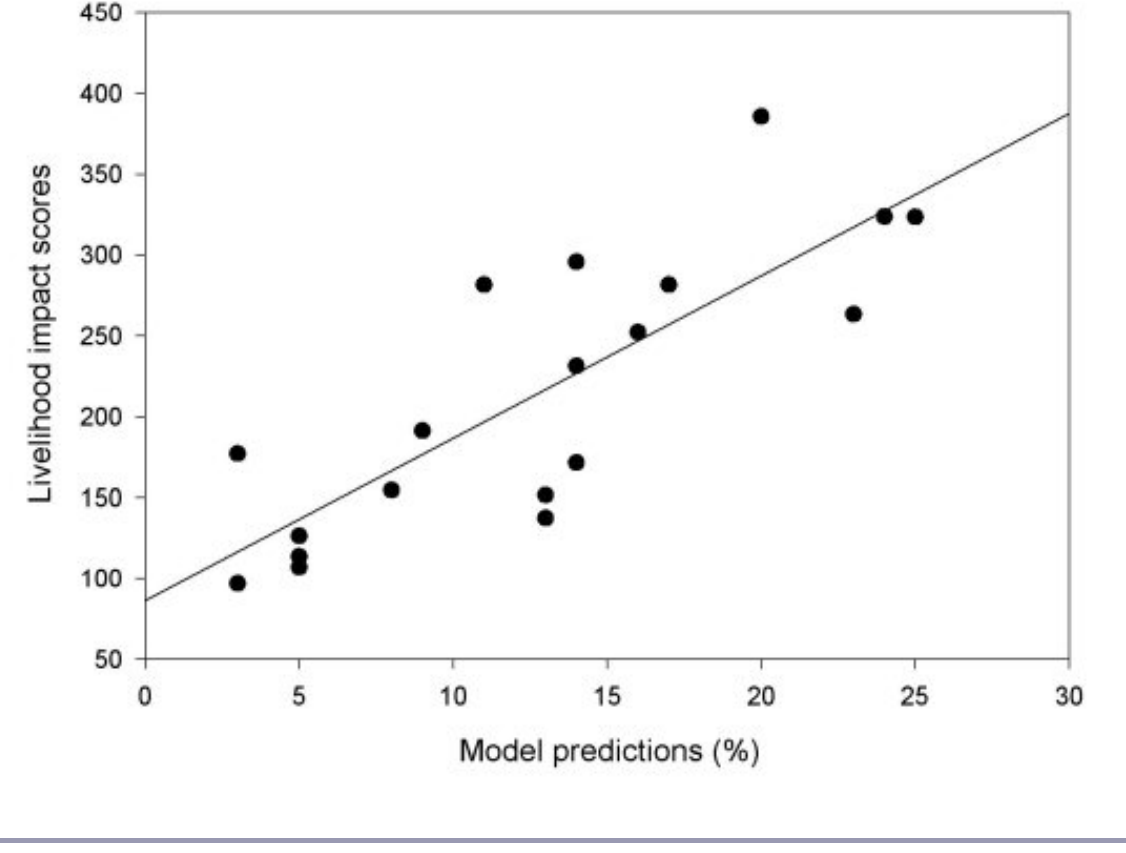
Fig. 3. Scatter plot illustrating the relationship between model predictions and livelihood impact scores for 19 individual case studies. Model predictions represent the summed probability values for the “Small increase” and “Large increase” states inferred for the nodes representing the change in assets resulting from commercialization. Data for the different asset types were pooled together for this analysis, but separate model predictions were made for each individual NTFP case study. Livelihood impact scores represent independent measures of the impact of NTFP commercialization on livelihoods assessed using the CIFOR indicators. Indicator scores were summed individually for each NTFP case study, pooling together data for both household- and community-level